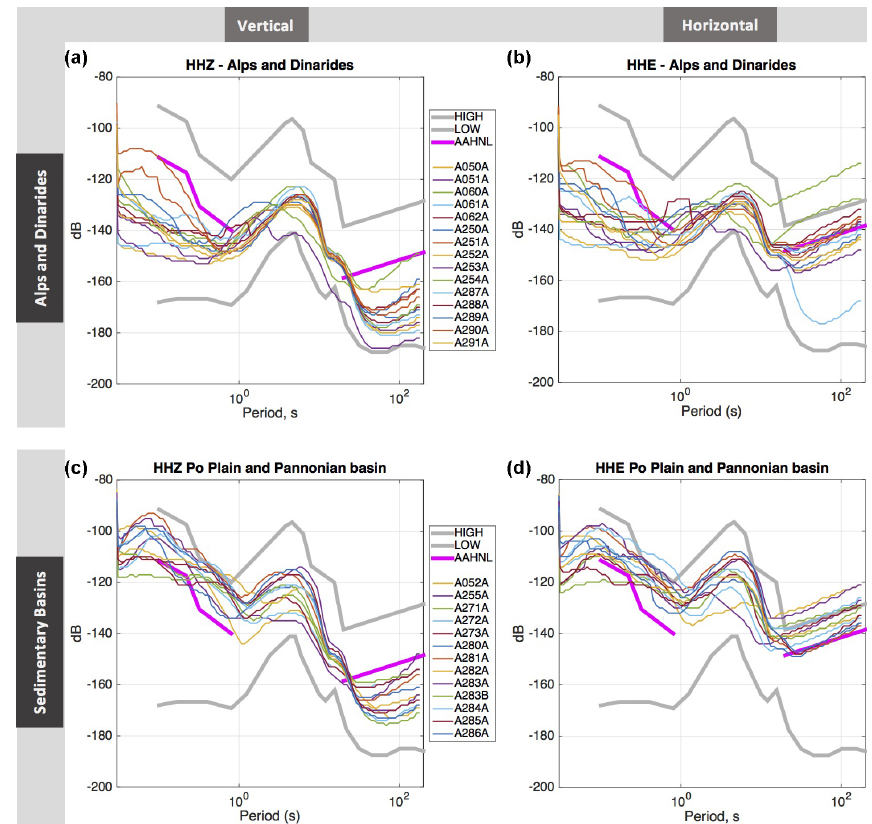
Figure 4. Median curves of the power spectral densities for the operating Swiss-AlpArray stations during the period from September 2015 to June 2016 divided in regions of installation (basins and mountains). Each line represents a single station. The light grey lines correspond to the NHNM and NLNM models, and the magenta thick line is the AlpArray noise level requirement. (a) Vertical component and (b) east– west horizontal component of the stations in the Alps and Dinarides. (c) Vertical component and (d) east–west horizontal component of the stations in the Po Plain and Pannonian basin. The A287A and the A252A are not strictly in the Alps and Dinarides but in the hilly parts of the Po Plain and Pannonian basin,